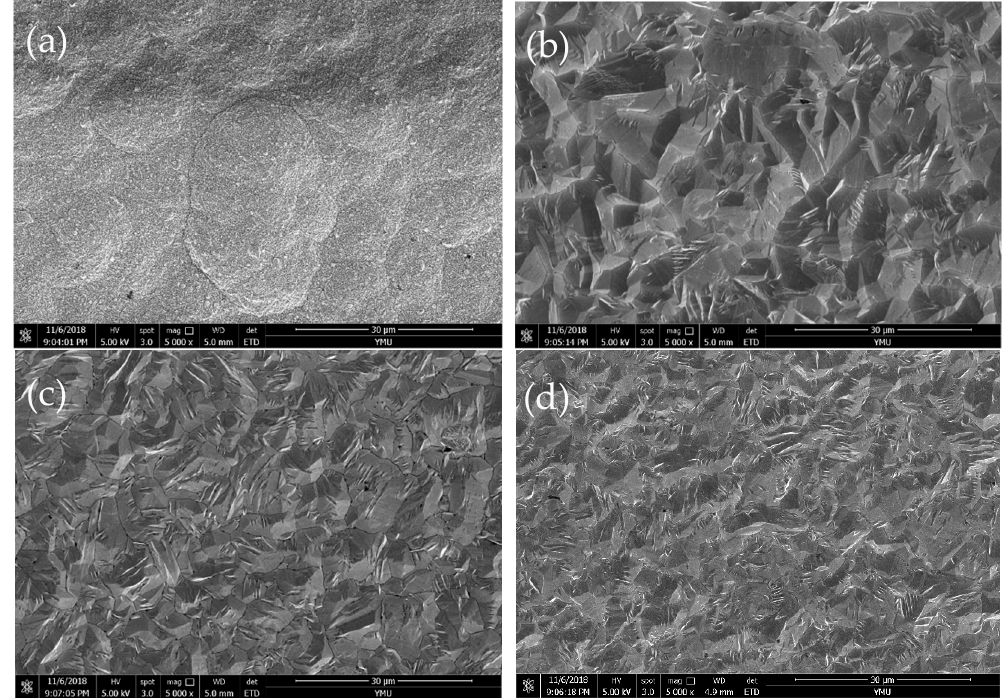
Figure 8. SEM images of Fe–Ni alloys electrodeposited from the chloride bath contained 0.6 M Ni 2+ ions at ( a ) 35 A·dm − 2 , 22 # , ( b ) 40 A·dm − 2 , 23 # , ( c ) 50 A·dm − 2 , 24 # , and ( d ) 60 A·dm − 2 , 25 # .